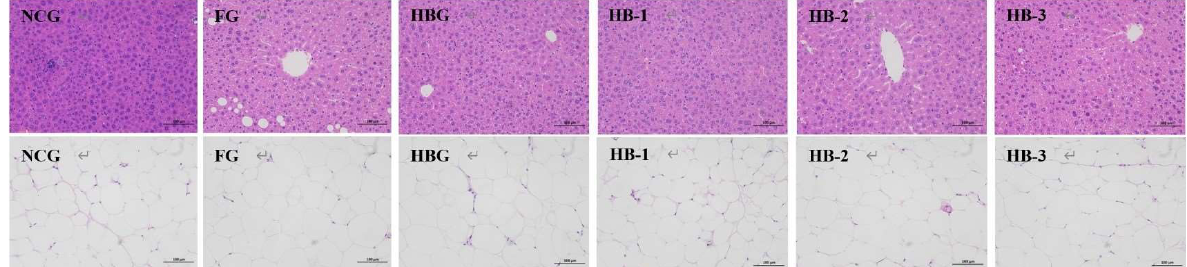
Figure 3. Hematoxylin and eosin (H&E) staining sections of liver and adipose tissue (100 μm). The first row of pictures represent liver tissue; the second row of pictures represent adipose tissue.